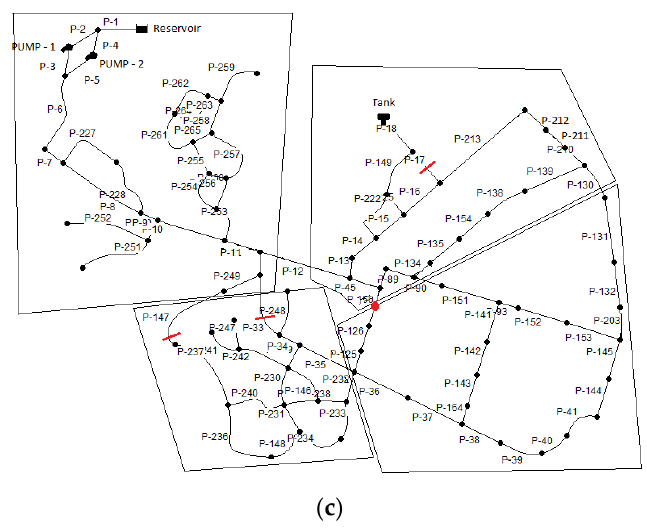
Figure 5. ( a ) The clusters with the highest average value for each sub-region using GMM-EM (green contour), ( b ) the clusters and the pipes in which isolating valves are installed are colored in red and ( c ) splitting of Net 22 into DMAs and the pipes with the red circle denote the selected pipes for PRV installation.